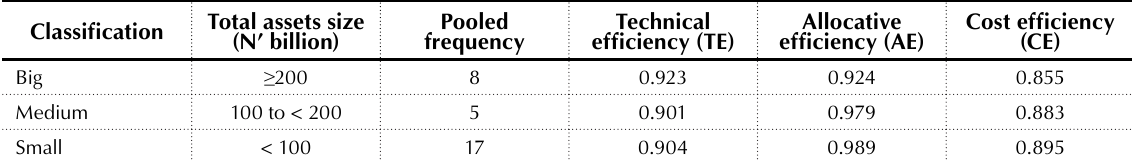
Table 7. A 2-year measured mean efficiency of the deposit money banks in 2004–2005 consolidation period